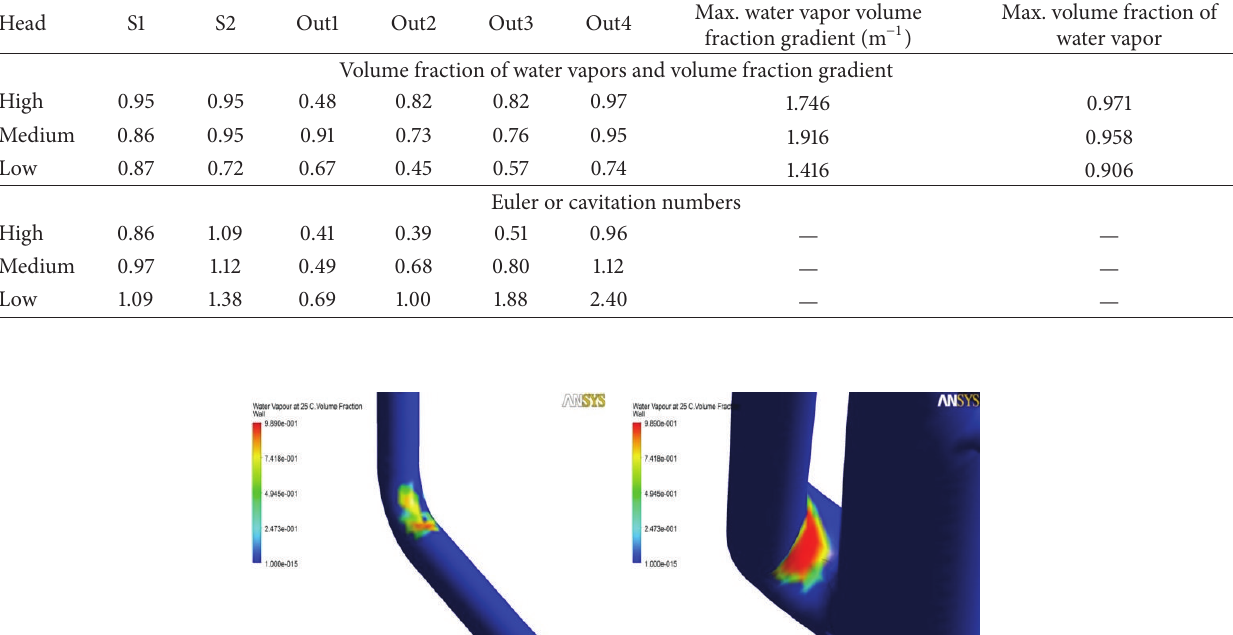
Table 12: Volume fraction of water vapors, volume fraction gradient, and Euler or cavitation numbers in Tunnel 3 under various head conditions.